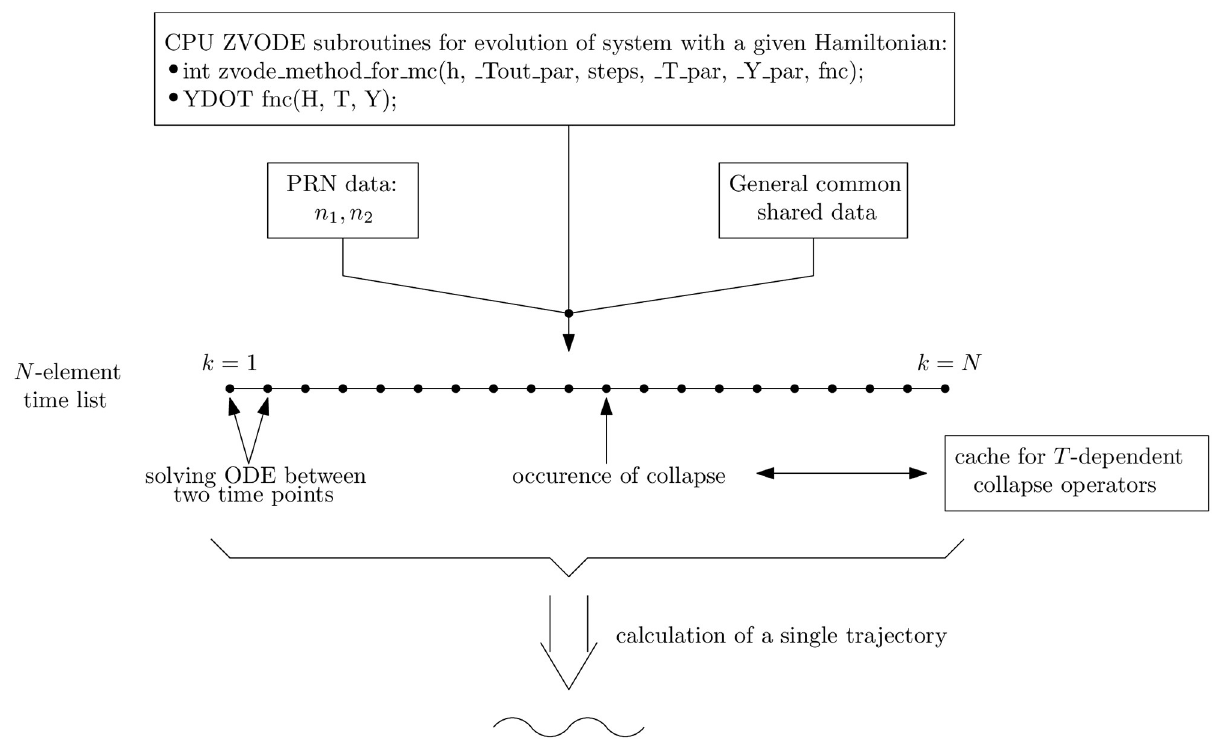
Fig 4. The general scheme presenting generation of a single quantum trajectory (PRN—Pseudo-random numbers; H—Hamiltonian data; zvode_method_for_mc—Subroutine to ODEs solving; _T_par—Time variable; _Y_par—Actual state of the system), fnc—Calculates the right side of